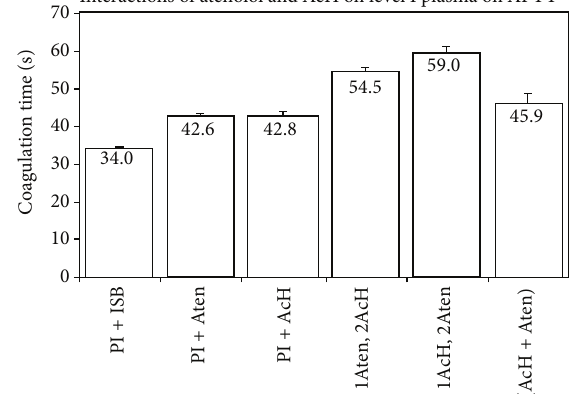
Figure 2: Interactions of atenolol and AcH on Level I plasma on APTT ( 𝑛 = 4 ; 𝑃 = 0.002 for atenolol and for AcH; 𝑃 = 0 for 1 Aten/2 AcH and for 1 AcH/2 Aten; 𝑃 = 0.02 for the AcH and Aten